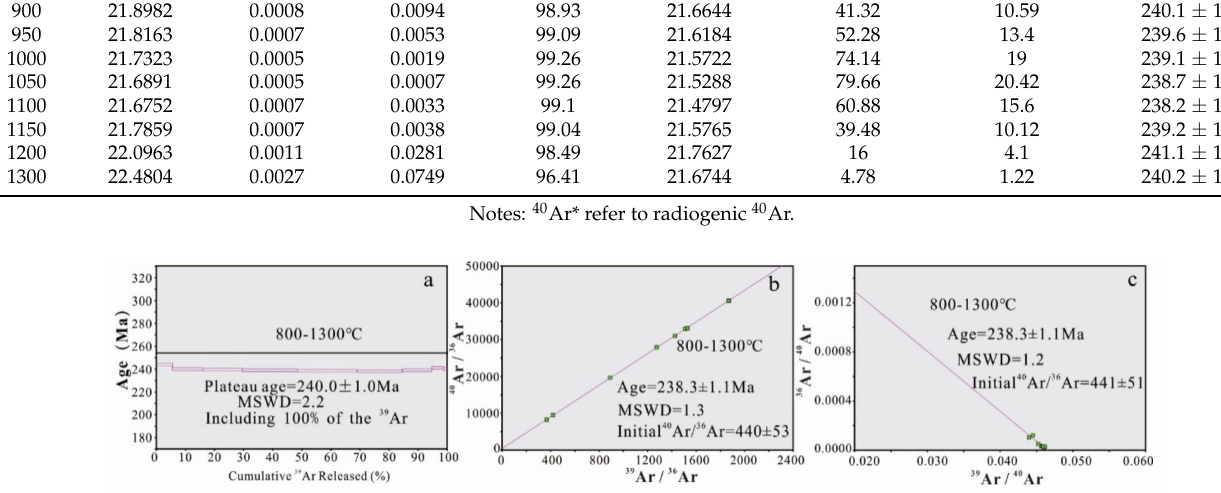
Figure 12. ( a ) Plateau, ( b ) isochron, and ( c ) inverse isochron 40 Ar– 39 Ar ages of muscovite (sample D18105-5; 1 σ ) from the Juyuan tungsten